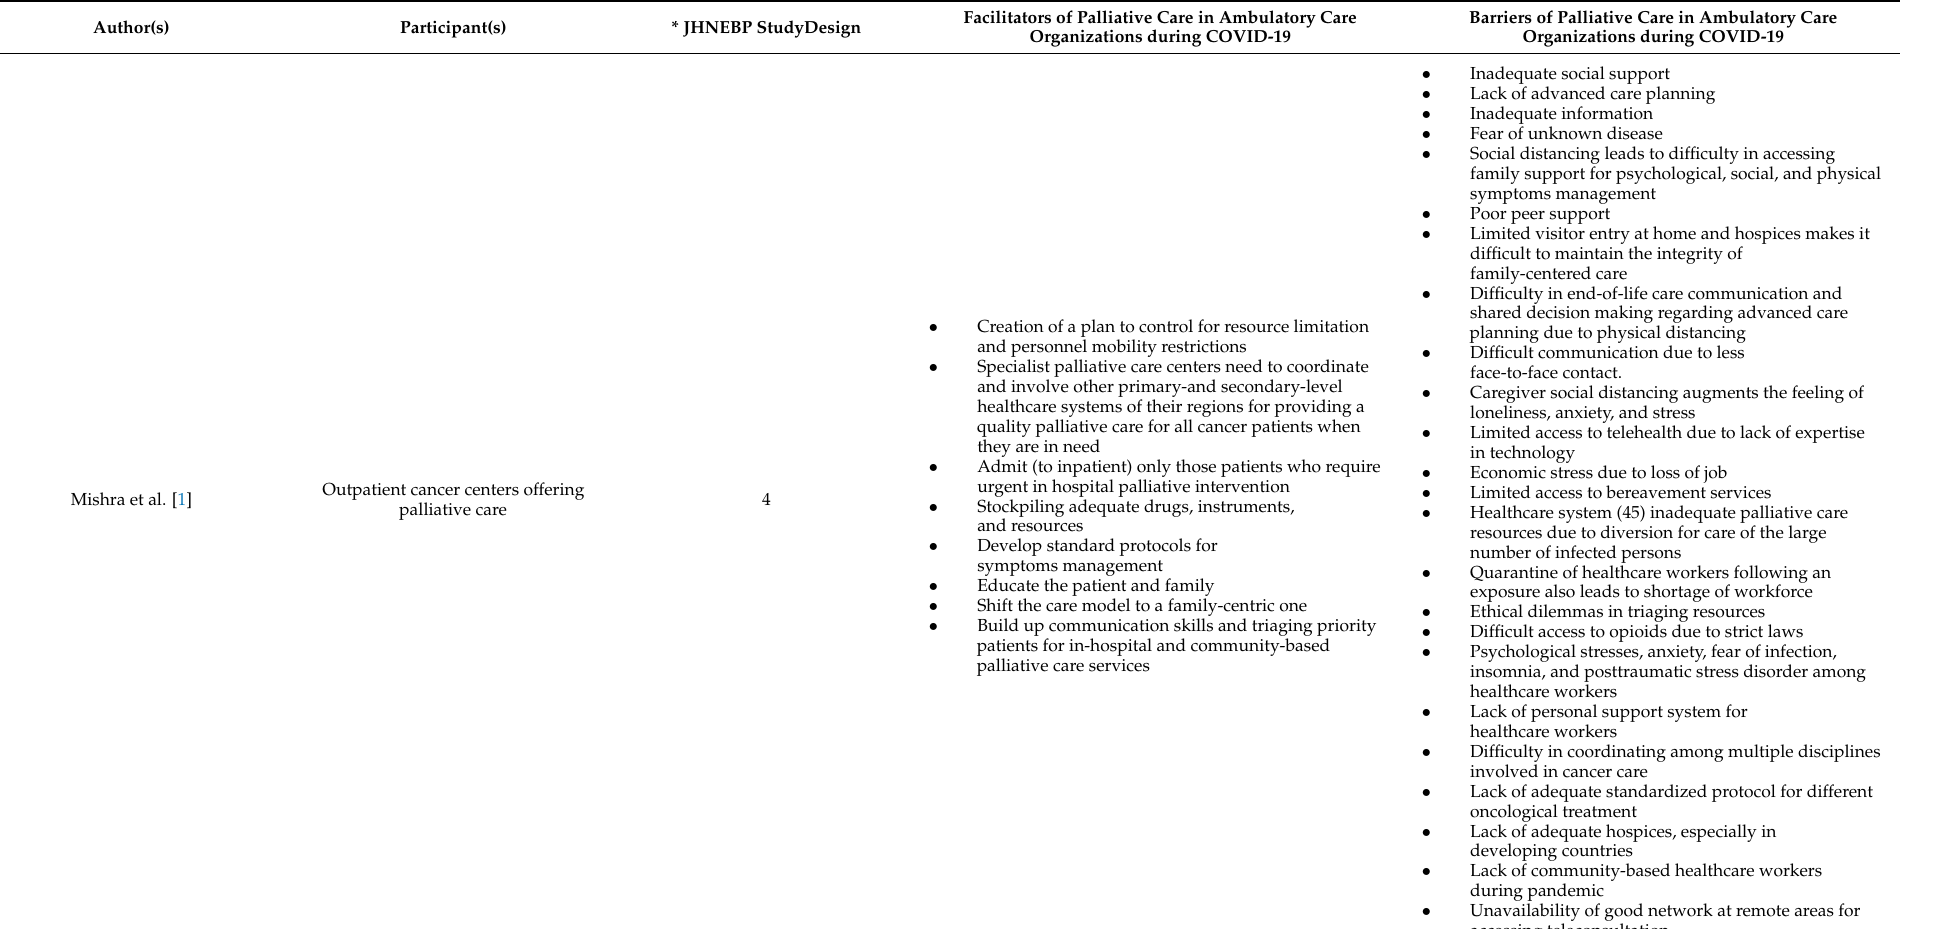
Table 2. Summary of findings ( n =